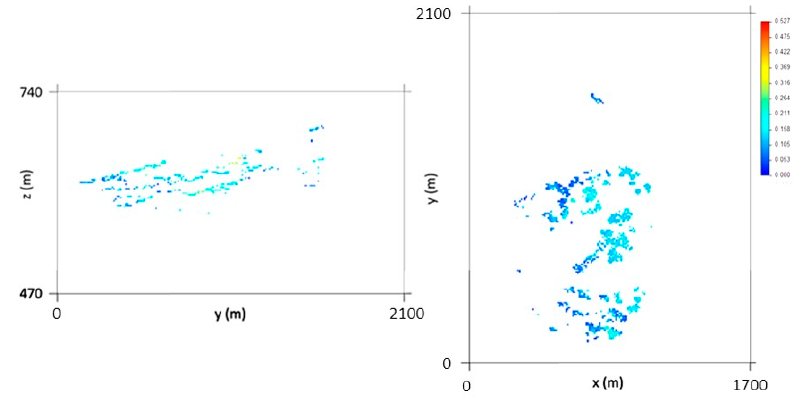
Figure 4. Declustering results for stope vein proportion: Px81 (left) and Pz75 (right).